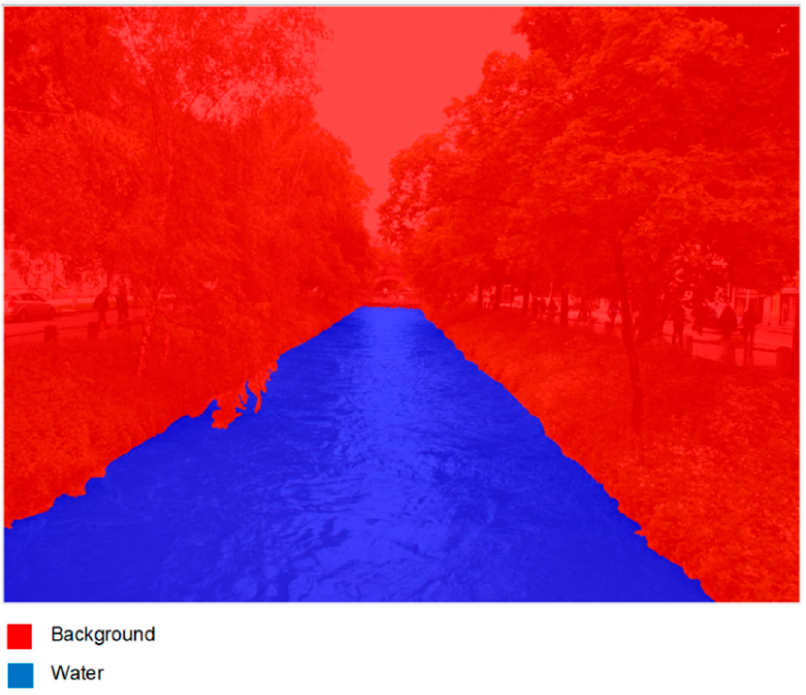
Figure 1. Example of a labeled image. The red region represents the background while the blue region represents waterbodies.